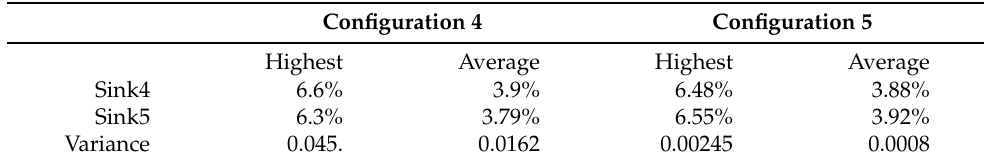
Table 6. Node migration: Energy consumption (86-nodes).